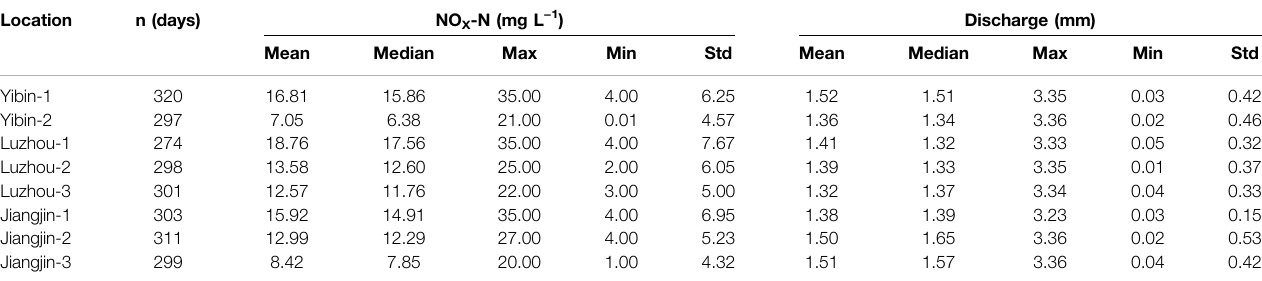
TABLE 1 | Summary of the dataset including daily nitrate concentration and discharge.